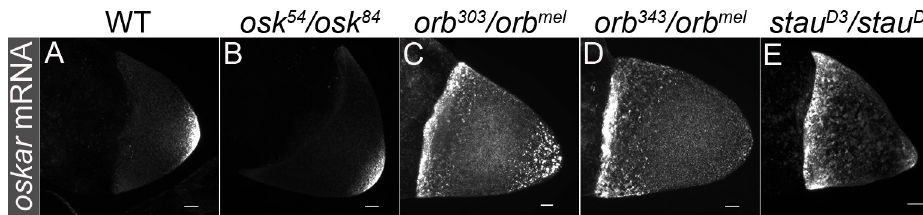
Fig 1. oskar mRNA is enriched at the oocyte anterior in orb mutants. (A-B) osk mRNA localizes to the oocyte posterior in WT and osk protein null ( 54/84 ) backgrounds. (C-E) In orb 303/mel , orb 343/mel and stau D3/Df osk mRNA is enriched at the oocyte anterior. Images are maximum intensity projections and all scale bars are 10